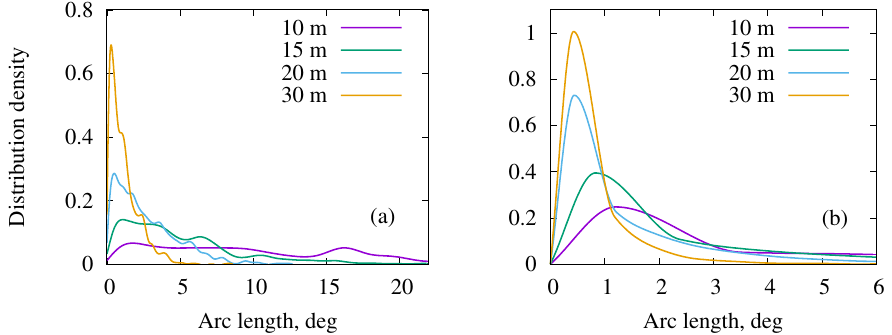
Figure 5. Distribution of open arc length at different distances in the pine stand: ( a ) for simulation and ( b ) from 2013 Leica TLS